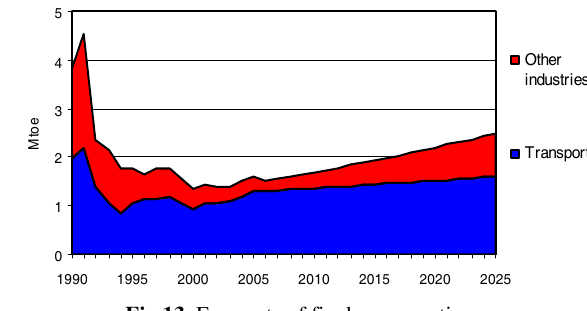
Fig 13. Forecasts of final consumption of petroleum